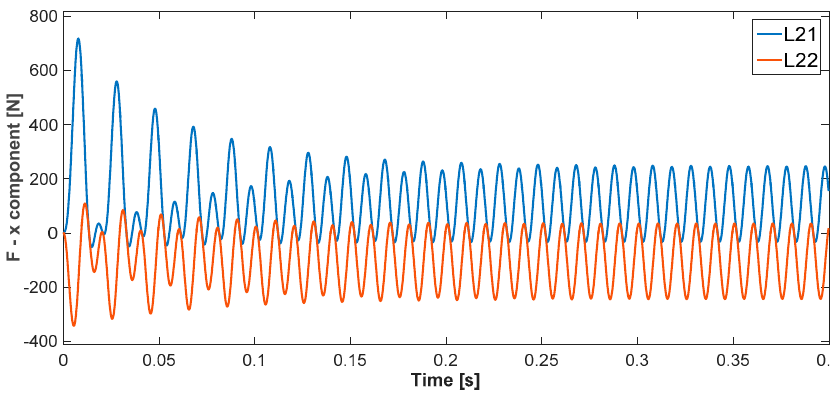
Figure 6. Electrodynamic forces on earthing knifes L11 and L12.